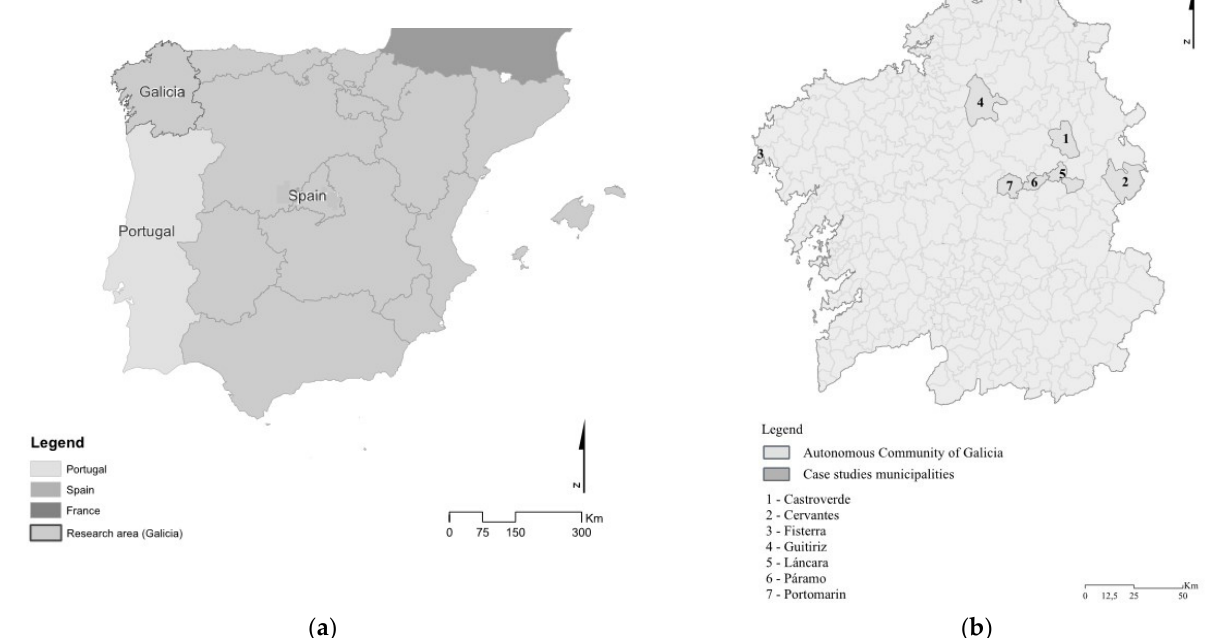
Figure 1. Research area location ( a ) and municipalities ( b ). Source: Authors.